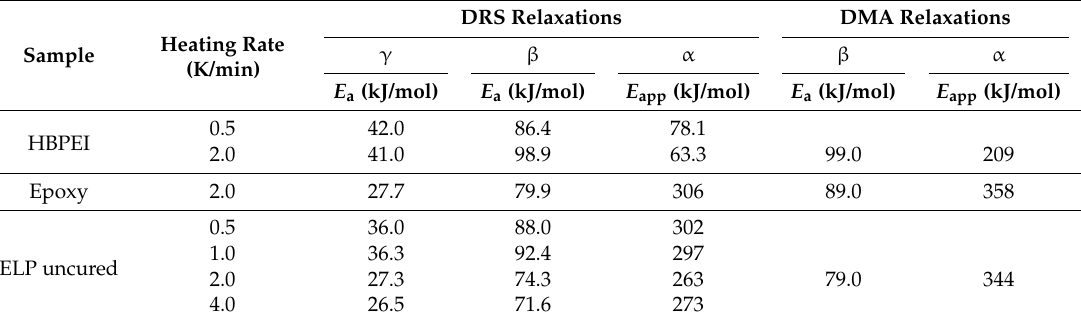
Table 3. Activation energies, E a , for the secondary relaxations, and “apparent” activation energies, E app , for the α -relaxation, for the HBPEI, epoxy and uncured ELP samples, obtained by DRS and dynamic mechanical analysis (DMA) at the different heating rates